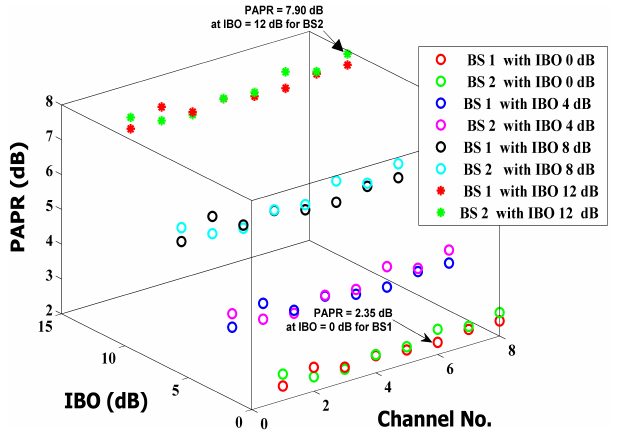
Figure 18. Estimated PAPR at different transmitting channels of serving BSs and IBO under nonlinear HPA